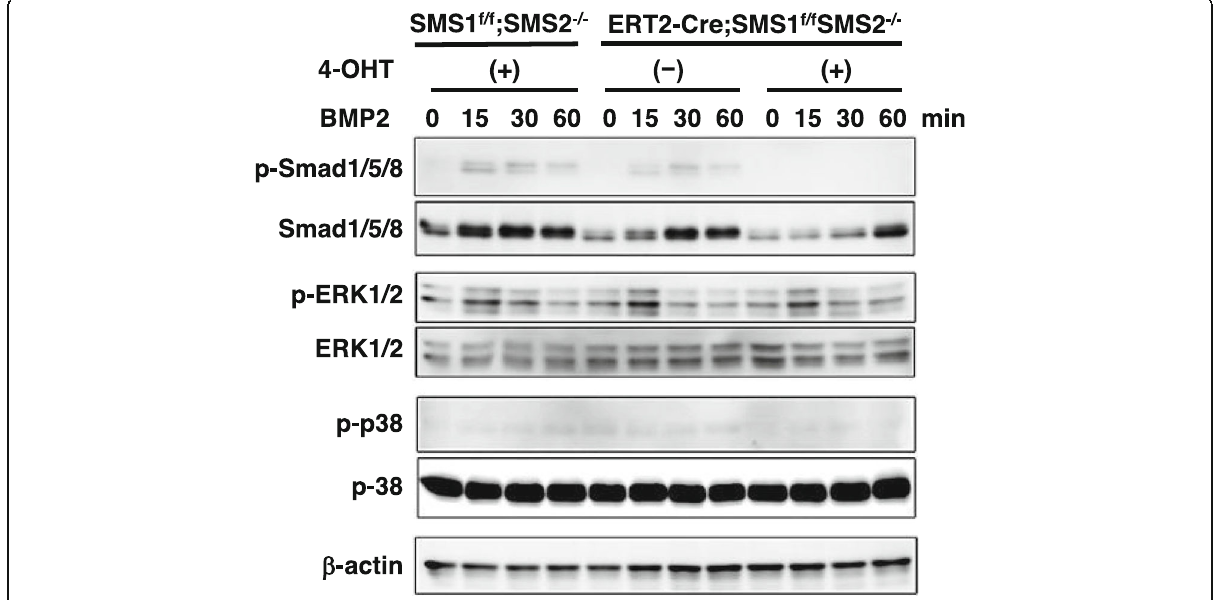
Fig. 6 Inactivation of SMS1 inhibited BMP2-induced Smad1/5/8 and p38 phosphorylation. The cellular phosphorylation levels of Smad1/5/8, ERK1/ 2, and p38 were determined by Western blot analysis of femoral osteoblasts from SMS1 f/f ;SMS2 − / − and ERT2-Cre;SMS1 f/f ;SMS2 − / − mice. After treatment with and without 1 μ M 4-OHT for 1 day, calvarial osteoblasts were serum starved for 12 h before BMP2 (50 ng/ml) stimulation for the indicated times, and then immunoblotted with antibodies specific to phospho-Smad1/5/8, phospho-ERK1/2, and